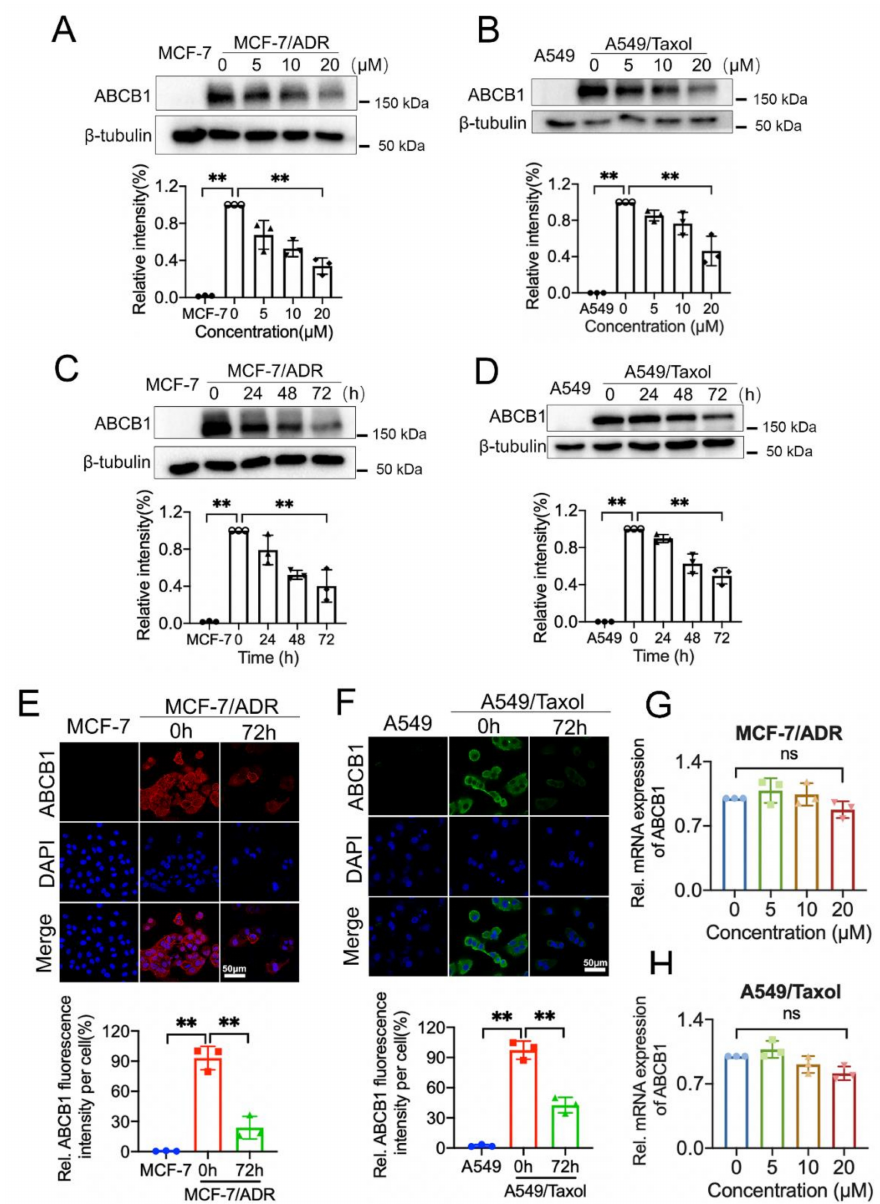
Figure 2. Rutaecarpine could alter the protein expression and subcellular localization of ABCB1 transporter. ( A ) ABCB1 expression in parent MCF-7 or MCF-7/ADR cells incubated with 0, 5, 10, 20 µ M of rutaecarpine for 48 h was detected by Western blot and the relative intensity is shown. ( B ) ABCB1 expression in parent A549 or A549/Taxol cells treated with 0, 5, 10, 20 µ M of rutaecarpine for 48 h was analyzed as in ( A ) and the relative intensity is shown. ( C ) ABCB1 expression in MCF-7 or MCF-7/ADR cells incubated with 20 µ M of rutaecarpine for 0, 24, 48, and 72 h was detected and the relative intensity is shown. ( D ) Detection and relative intensity of ABCB1 expression in A549 or A549/Taxol cells incubated with 20 µ M of rutaecarpine for 0, 24, 48, and 72 h are shown. ( E ) Subcellular localization of ABCB1 expression in MCF-7/ADR cells incubated with 20 µ M of rutaecarpine for 72 h. ( F ) Subcellular localization of ABCB1 expression in A549/Taxol cells